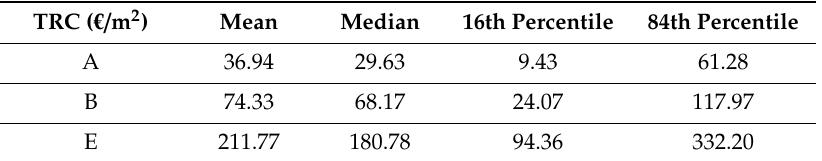
Figure 15. TRC depending on the usability judgment (costs for judgment “A” only consider buildings in DS1). Table 6. Mean, median, 16th and 84th percentiles for the estimated TRC depending on the usability judgment (costs for judgment “A” only consider buildings in DS1).